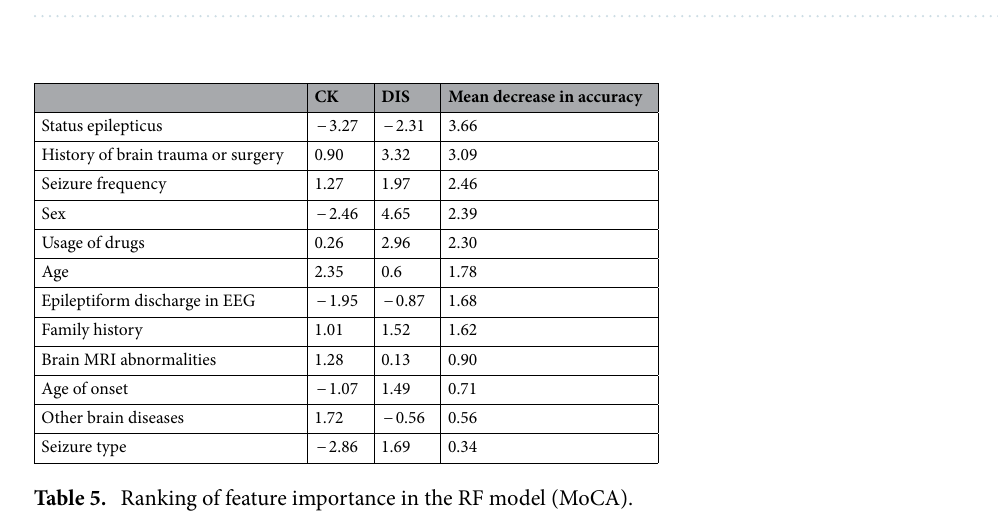
Table 4. Results of cross-validation for different machine learning algorithms using MoCA data.